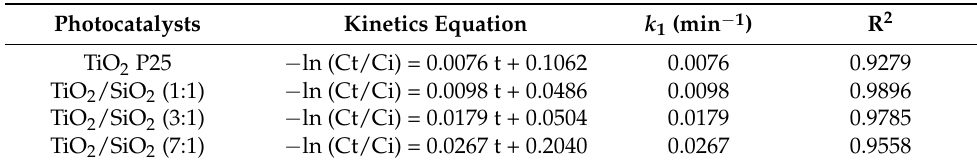
Table 10. The kinetic study of the photocatalysts.